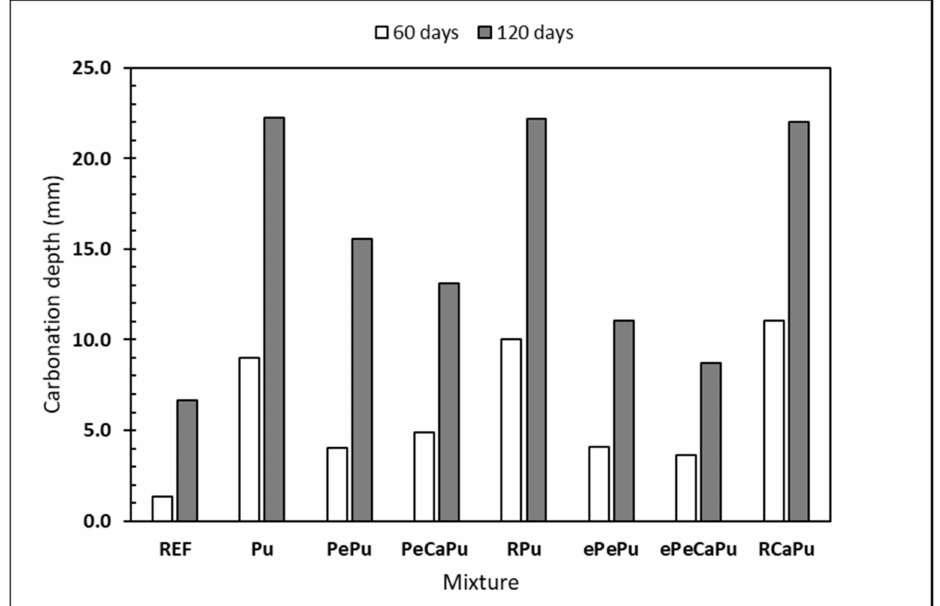
Figure 5. Carbonation depth of LWC mixtures, after 60 and 120 days of